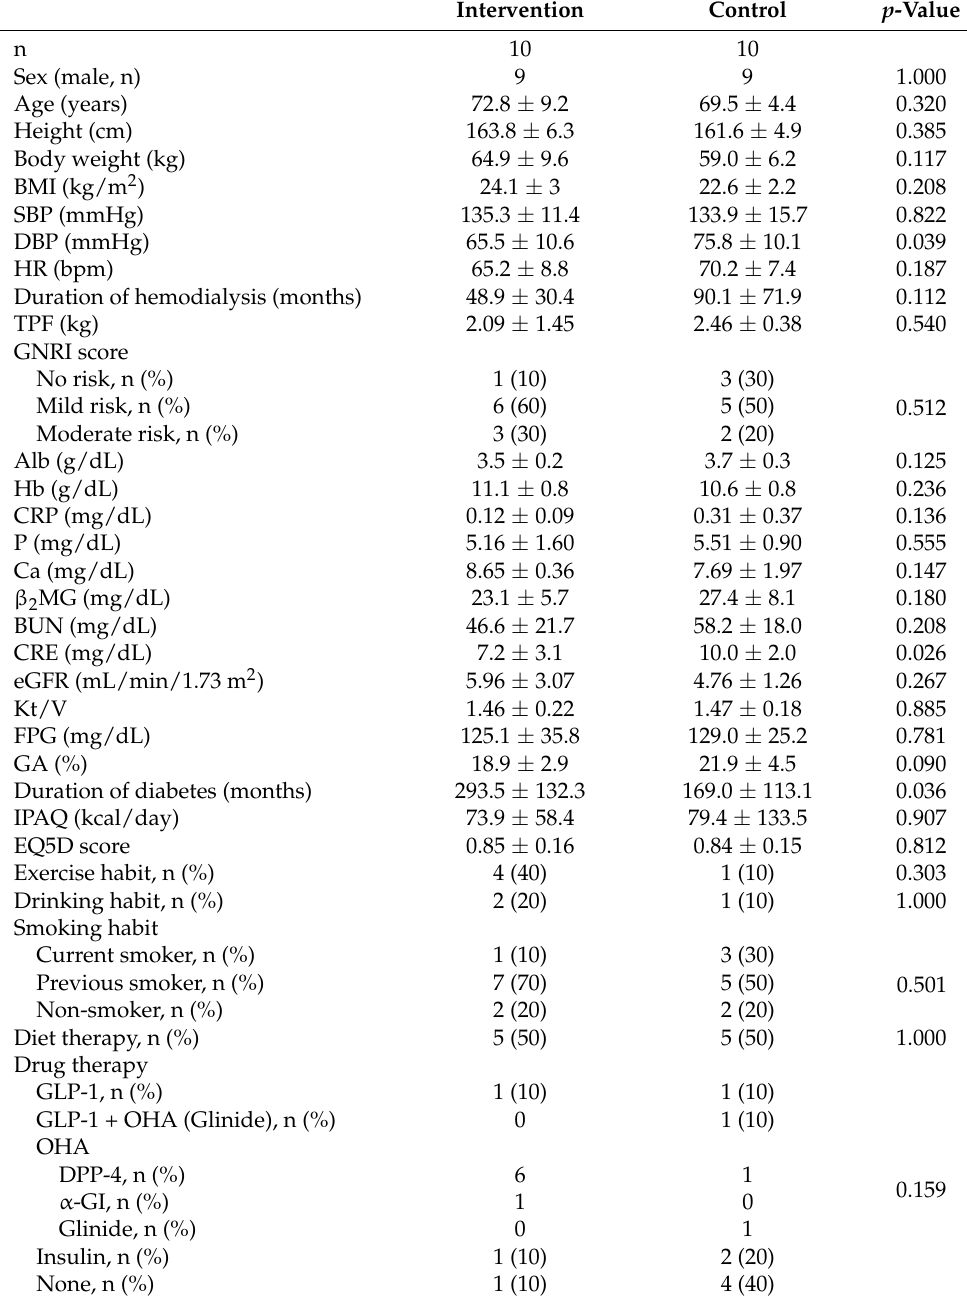
Table 1. Clinical indicators of the intervention and control